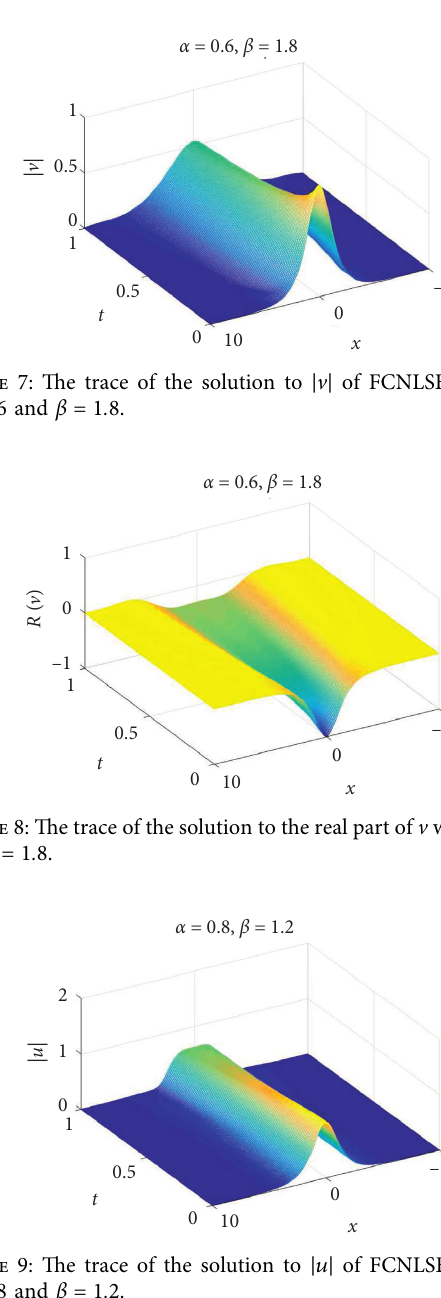
Figure 6: The trace of the solution to the real part of u with α � 0 . 6 and β � 1 . 8.